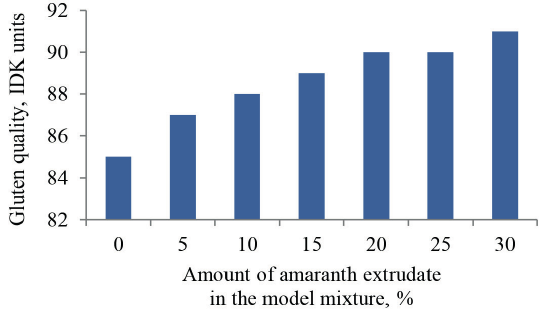
Figure 7 Gluten quality in the model mixtures of wheat flour and amaranth extrudate